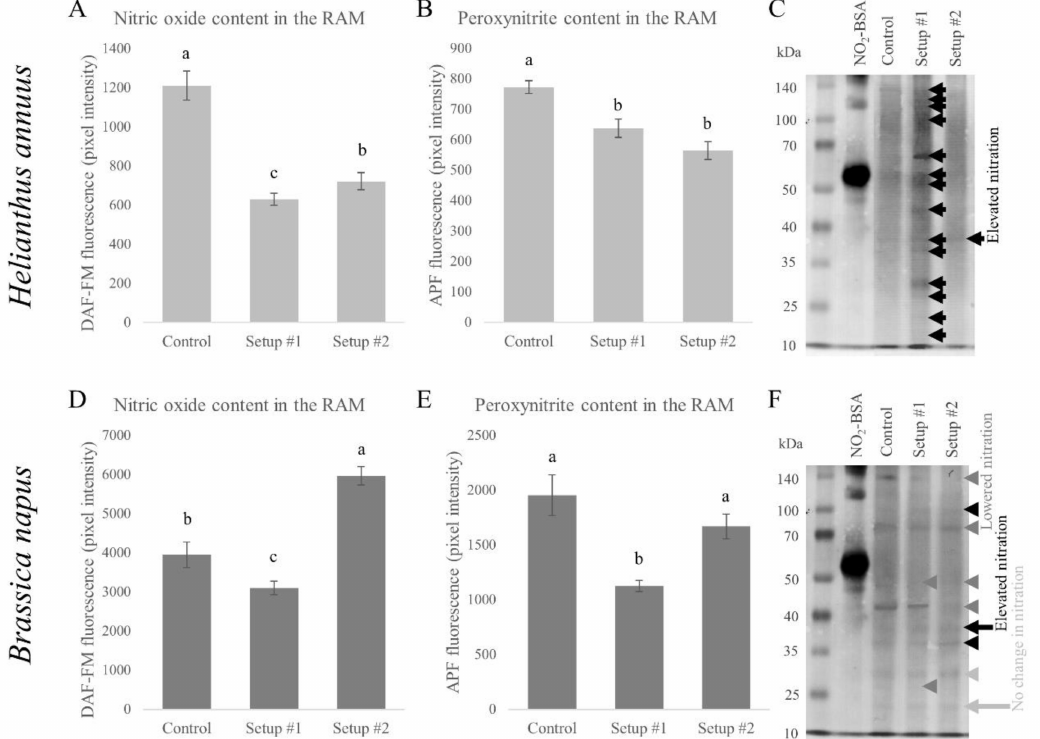
Figure 6. Changes in the fluorescence consistent with nitric oxide in sunflower ( A ) and rapeseed ( D ) root tips. Fluorescence proportional to peroxynitrite content in sunflower ( B ) and rapeseed ( E ) root tips. Di ff erent letters indicate significant di ff erences according to Duncan-test ( p < 0.05). Representative immunoblot showing protein tyrosine nitration in the roots of sunflower ( C ) and rapeseed ( F ) grown in di ff erent rhizotron setups. Black arrows show elevated nitration; dark grey arrows show lowered nitration compared to the control. Light grey arrows indicate protein bands with not altered nitration due to the model sewage